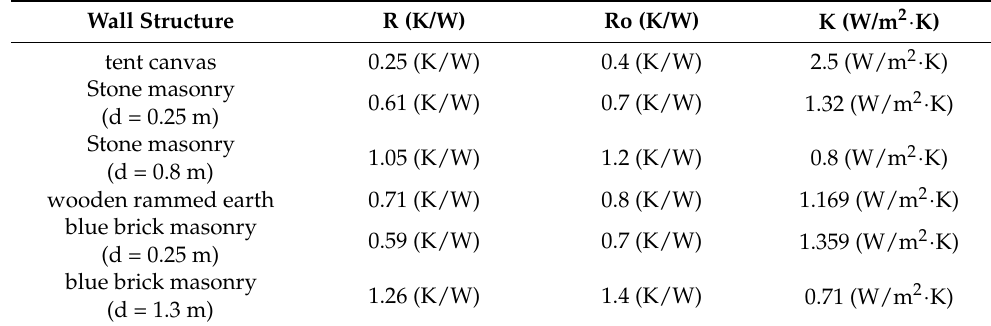
Table 4. Thermal performance index of the envelope building